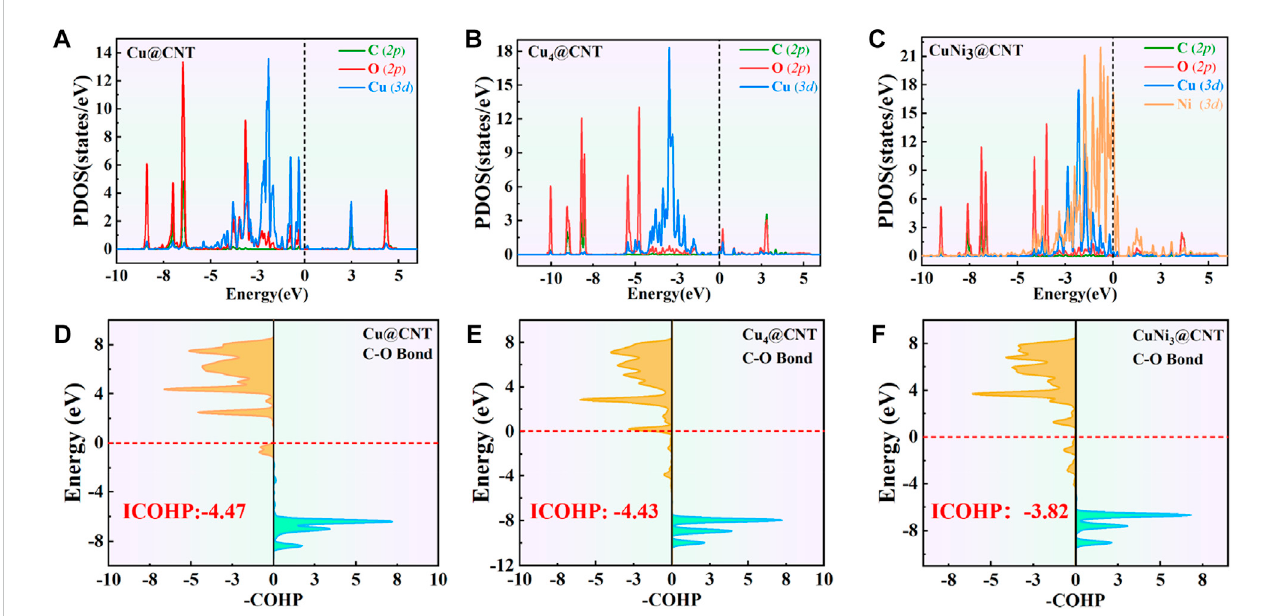
FIGURE 3 (A – C) Projecteddensityofstate(PDOS)plots. (D – F) ProjectedcrystalorbitalHamiltonpopulation(pCOHP)ofCO and CuNi 3 @CNTs. The dotted line represents the Fermi energy